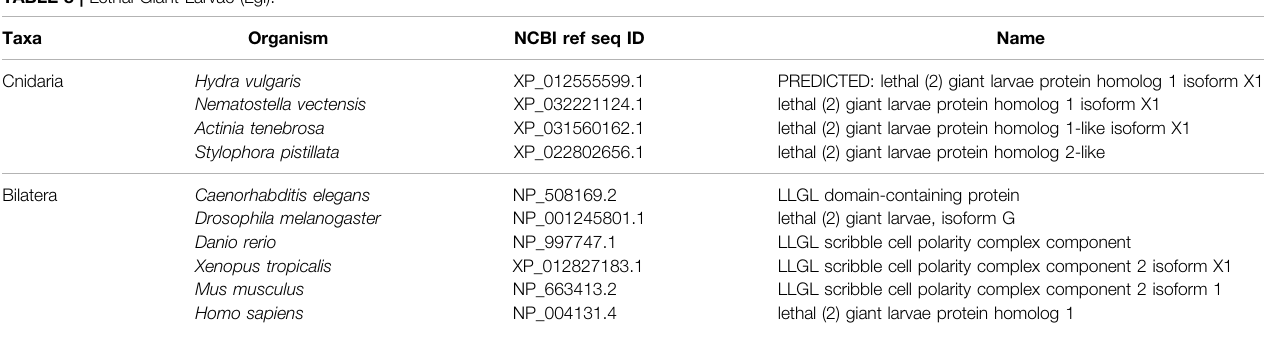
TABLE 8 | Lethal Giant Larvae (Lgl).